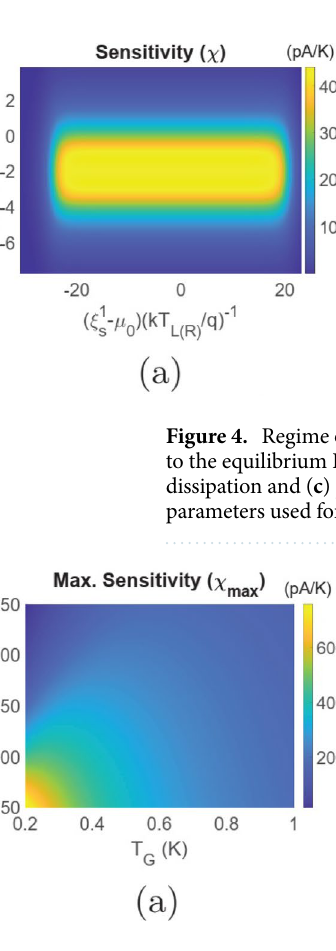
Figure 5. Maximum sensitivity and parameters at maximum sensitivity for the dual dot thermometer. Colour plot demonstrating the variation in ( a ) maximum sensitivity ( χ max ) ( b ) power dissipation at maximum sensitivity and ( c ) performance coefficient at maximum sensitivity with variation in the Coulomb coupling energy ( U m ) and target reservoir temperature ( T G ). The parameters used for simulation are T L ( R ) = 300 mK, γ c = 10 µ eV and V = 1.1